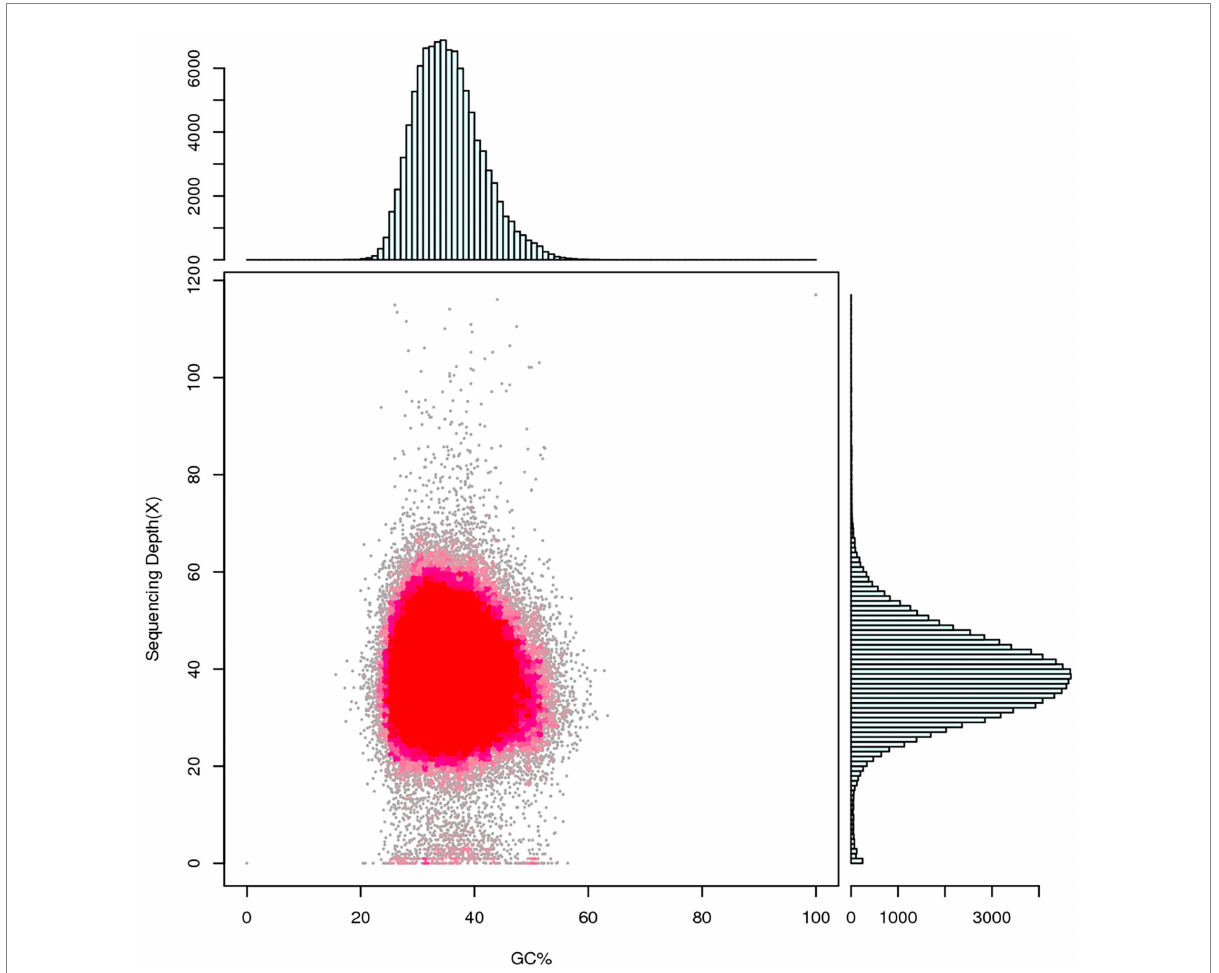
FIGURE 3 Statistical diagram of correlation analysis between GC content and sequencing depth. Summarize the GC bias and repetitive sequences of the genome by counting the GC content and reads coverage depth of assembled sequences. The horizontal coordinate indicates the GC content, the vertical coordinate indicates the sequencing depth, the right side is the sequencing depth distribution, and the upper side is the GC content